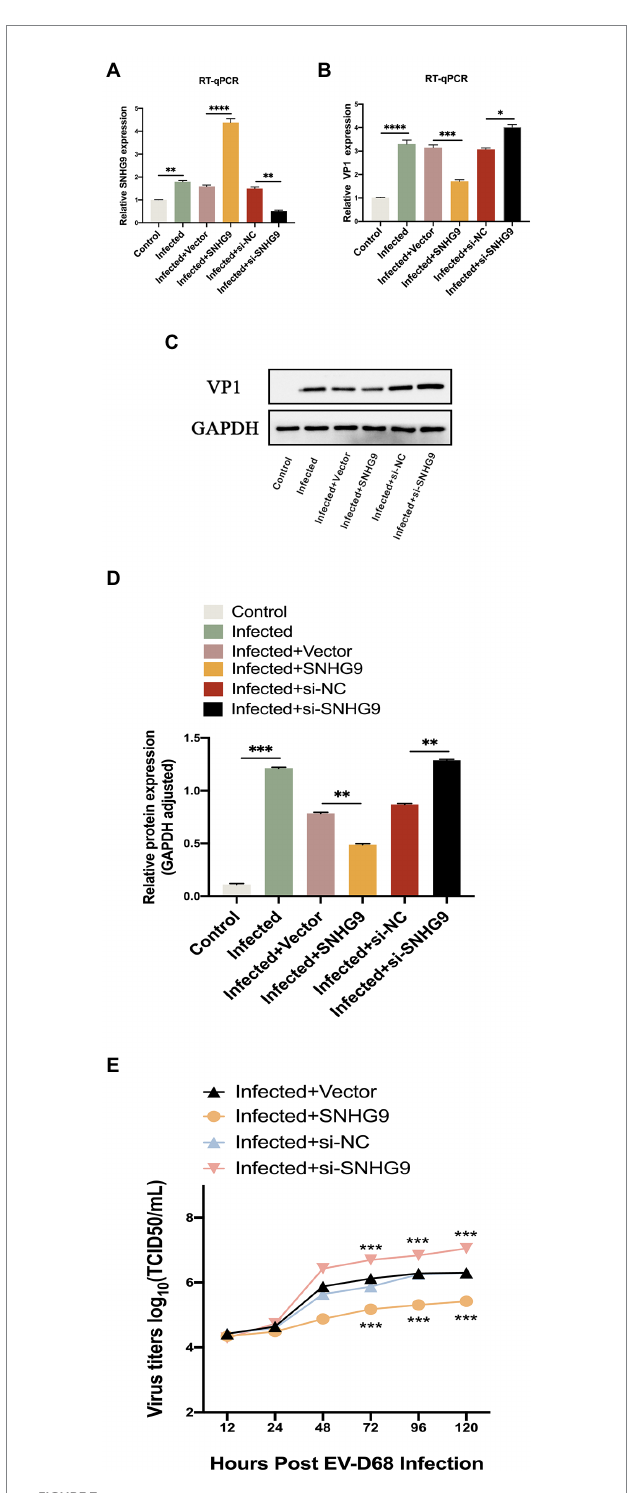
FIGURE 7 Effect of SNHG9 on viral replication in EV-D68-infected RD cells. RD cells were transfected with SNHG9-overexpression plasmid or si-SNHG9 and then infected with EV-D68 for 12 h. (A,B) Expression of SNHG9 and VP1 in RD cells was detected by qRT-PCR (* p < 0.05, ** p < 0.01, *** p < 0.001, **** p < 0.0001). (C,D) Western blot was utilized to evaluate viral VP1 protein levels. The data are expressed as mean ± SD ( n = 3) * p < 0.05, ** p < 0.01, and *** p < 0.001 vs. the control, vector, and si-NC groups. (E) For the replication levels of viral infections, viral titers were estimated. The data are expressed as mean standard deviation (n = 3) * p < 0.05, ** p < 0.01, *** p < 0.001 in comparison to the vector and si-NC